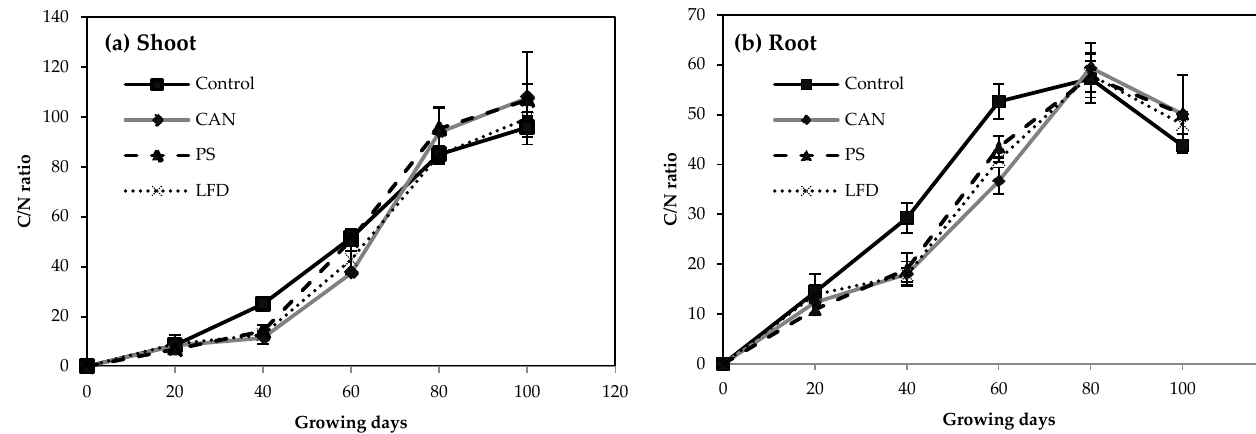
Figure 2. The C/N ratio (mean ± standard deviation; n = 4) of the shoot ( a ) and root ( b ) in maize growing pots, control = no N fertilizer, CAN = calcium ammonium nitrate, PS = pig slurry, LFD = liquid fraction of digestate.